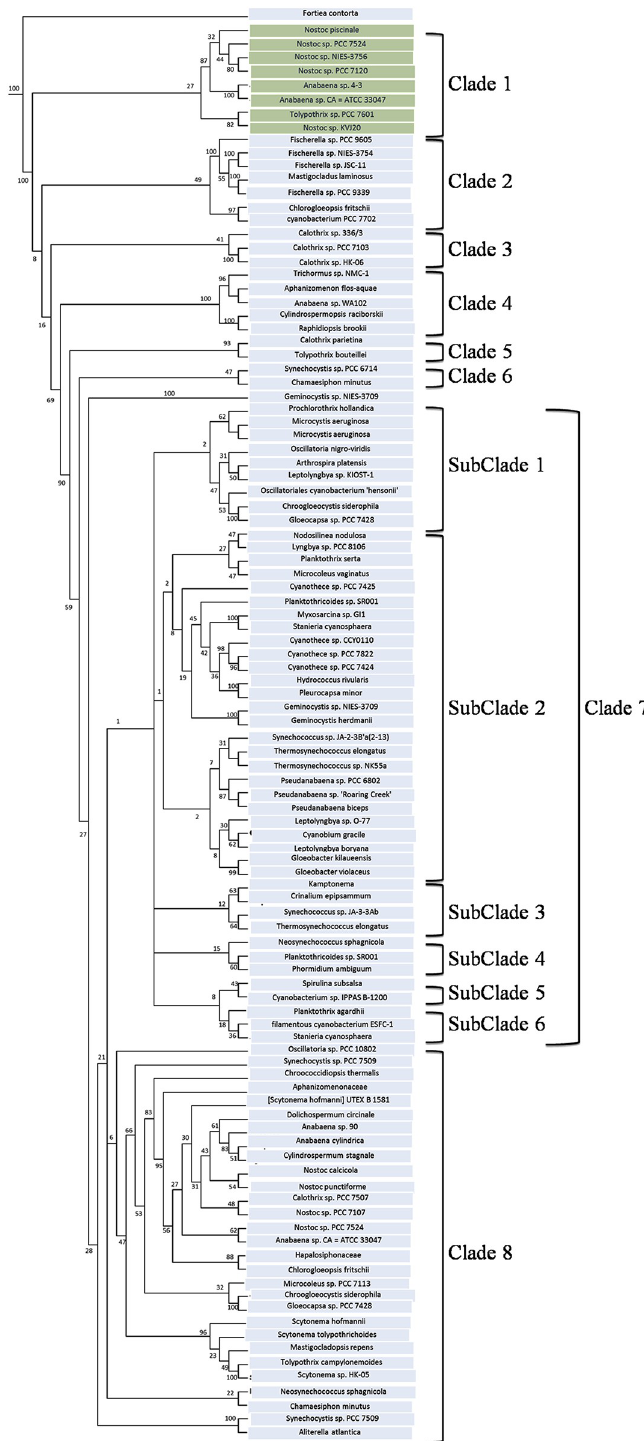
Fig 5. Phylogenetic tree of deduced nrtD protein. The tree was constructed by PHYLIP programs using Seqboot, Protdist, Neighbour and Consense methods. Bootstraping (1000 times) was performed to obtain support values for each branch. Values are shown at the nodes of each branch